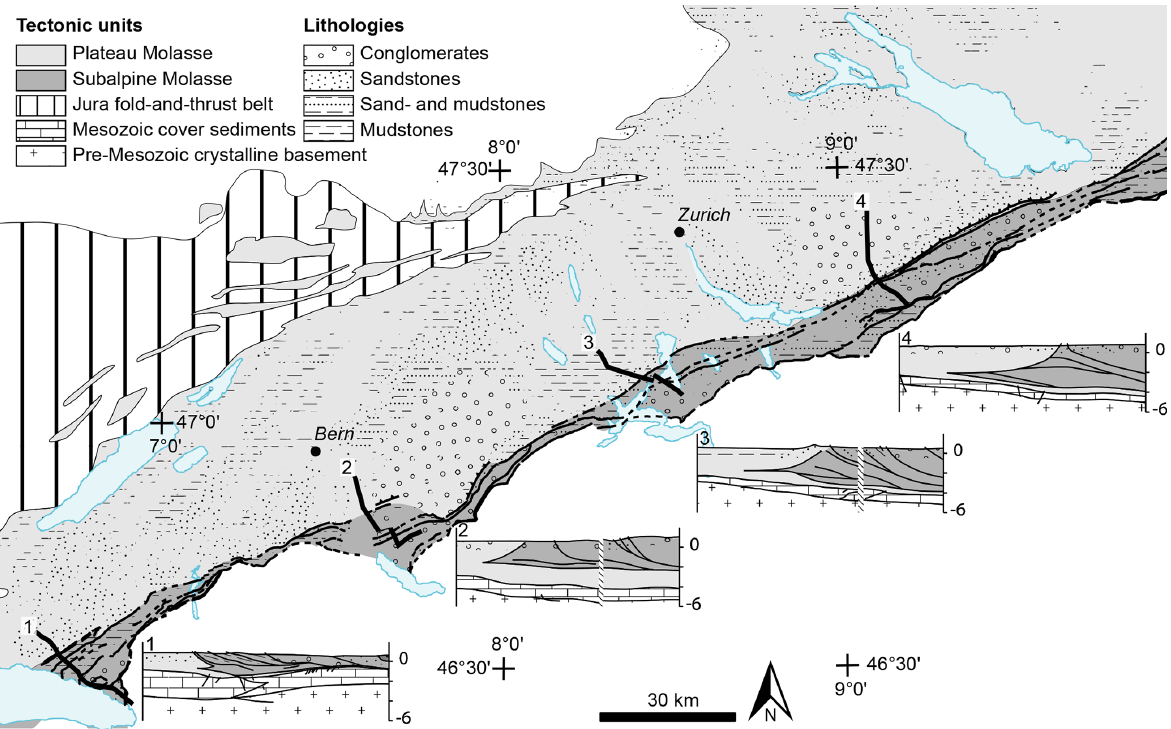
Figure 7. Litho-tectonic map of the Swiss Molasse Basin (modified from Landesgeologie, 2005). Cross sections 1–4 are based on 2D seismic interpretation (cross section 2 – Mock and Herwegh, 2017; cross sections 1, 3, and 4, Sommaruga et al.,